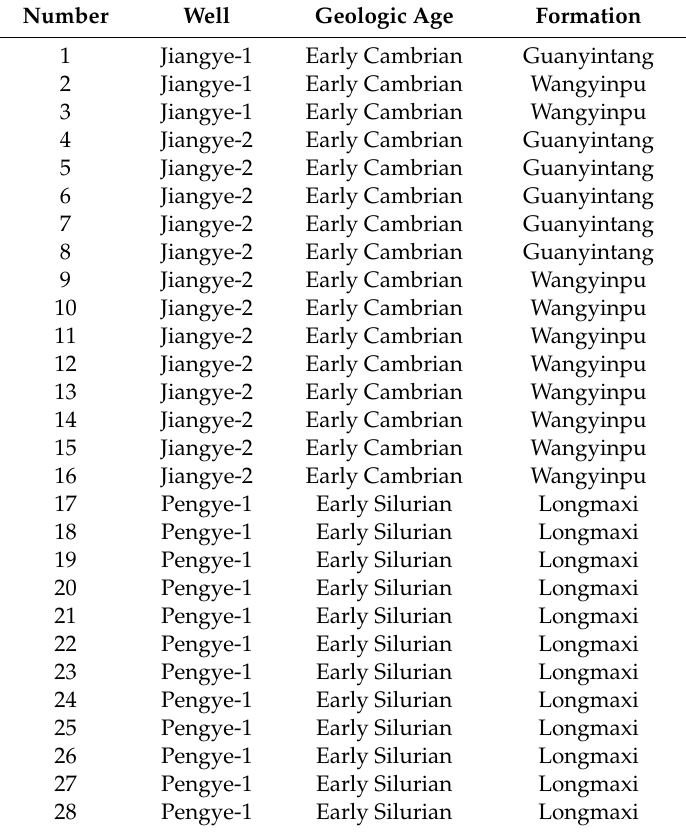
Table 2. Experimental numbers, wells, geologic age, and formation names of core samples. The well locations can be seen in Figure